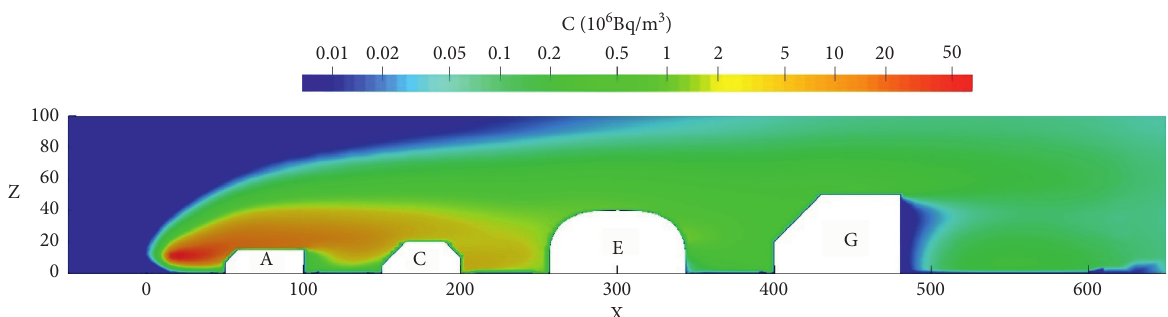
Figure 3: Vertical distribution of radioactive pollutants (in the XZ plane, where y � 225 and T � 300 s